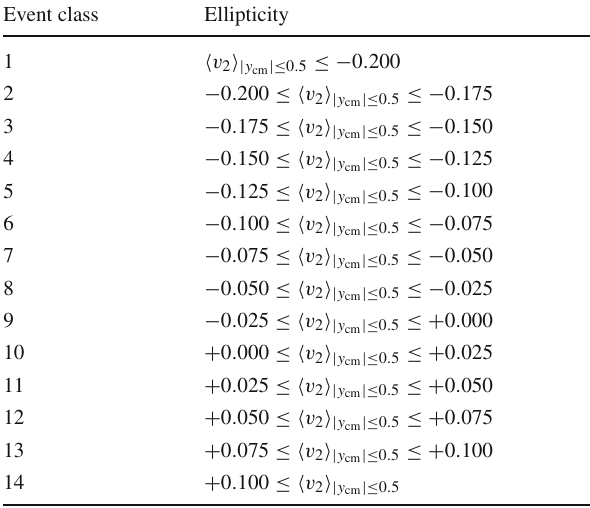
Table 1 Definition of the event classes based on the elliptic flow value (ellipticity) at midrapidity in semi-peripheral Au+Au collisions at 1.23 AGeV using UrQMD with a hard EoS Event